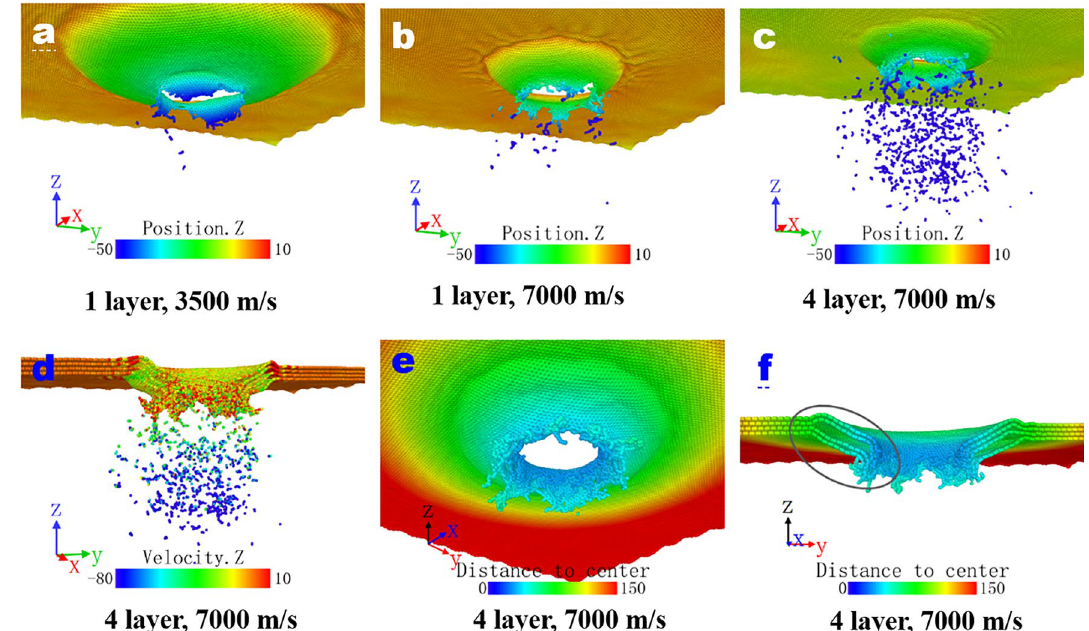
Figure 5. The final morphologies of single-layer graphene subjected to impact velocities of 3500 m/s ( a ) and 7000 m/s ( b ) respectively; the position ( c ) and velocity ( d ) along the Z-direction position, bottom view ( e ) and cross-section view ( f ) of the quadruple-layer graphene membrane at 7000 m/s. Distances are identified and visualized by Ovito Version 2.9.0 (https:// www. ovito.